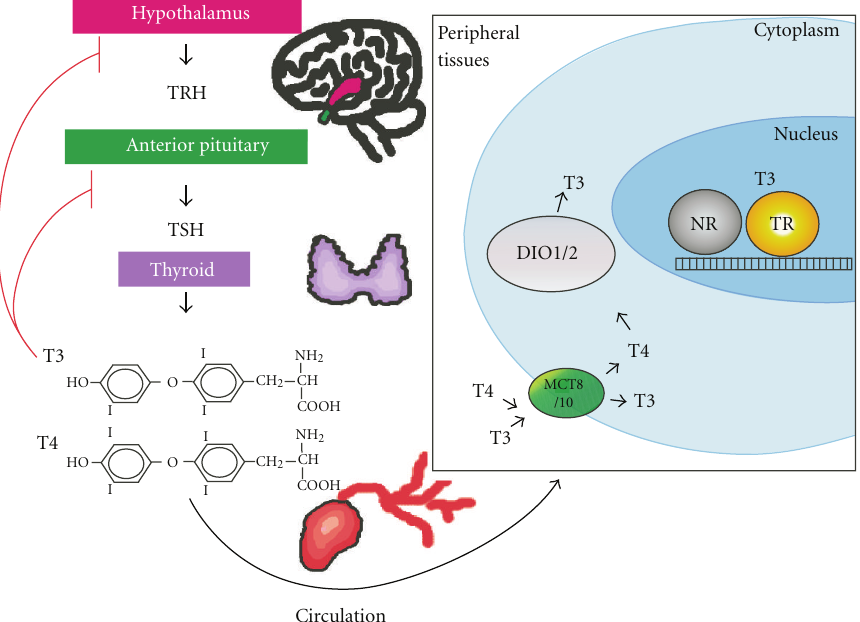
Figure 1: Regulation of thyroid hormone synthesis and activity. TRH is produced in the hypothalamus (shown in pink) and stimulates the anterior pituitary (shown in green) to create TSH, which stimulates the follicular cells of the thyroid gland (purple) to produce T3 and T4. T3 and T4 circulate through the blood to the peripheral tissues (see box at right), where they are transported across the cell membrane into the cytoplasm by MCT8/MCT10 (green oval). T4 can be converted to T3 by deiodinase type 1 and deiodinase type 2 (DIO1/2, gray sphere). Both T3 and T4 can enter the nucleus and regulate TR activity. TR is shown here as a yellow sphere bound to DNA. On most sites, TRs can dimerize, either as homodimers or as heterodimers, with another nuclear receptor partner (NR, dark gray